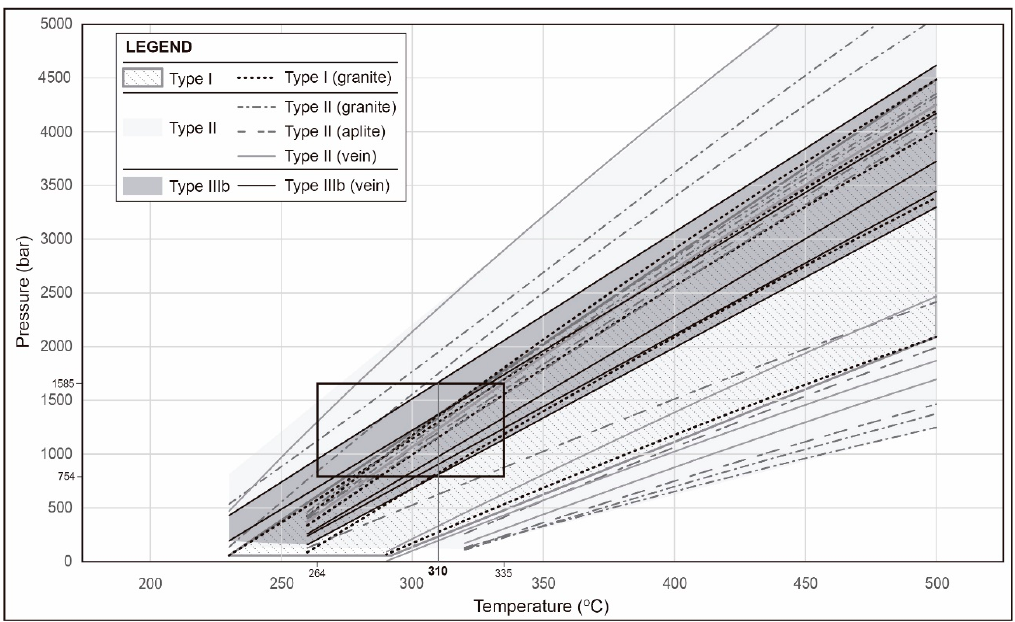
Figure 19. Pressure–temperature (P-T) diagram with isochores of the different fluid inclusion types in the Passa Três gold deposit. The black rectangle represents entrapment conditions of mainly type IIIb fluid inclusions, those associated with the mineralisation stage, and constraints from chlorite geothermometry (temperatures of formation from 264 to 335 °C; average temperature of 310 °C).